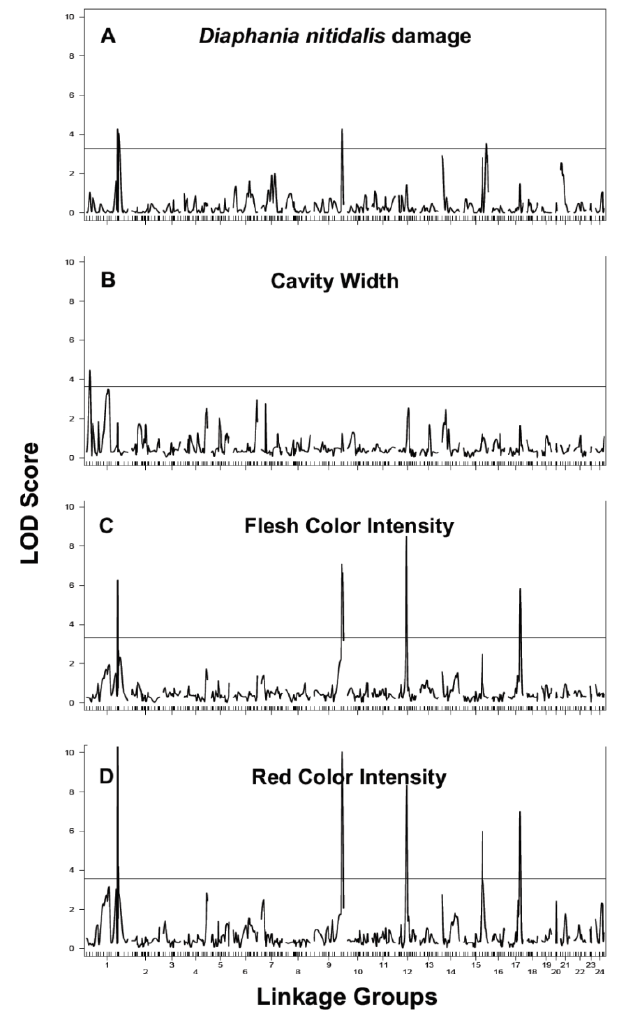
Figure 2. Significant QTLs identified in the BC 1 pumpkin population. ( A ) Diaphania nitidalis